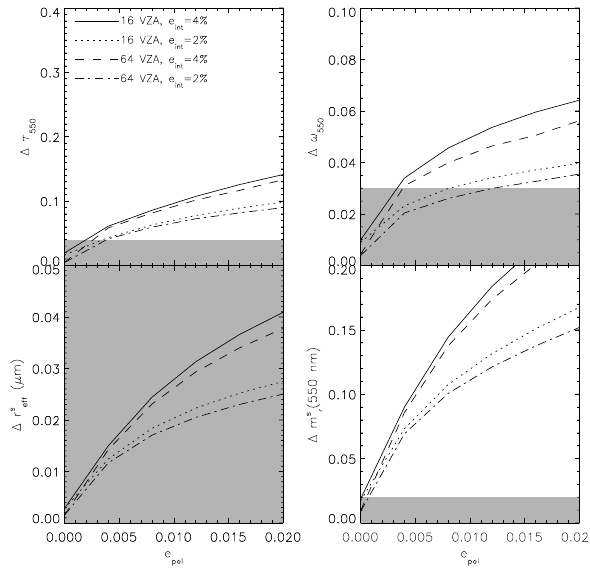
Fig. 5. Same as Fig. 4 but for errors that are correlated for different wavelengths and different viewing angles. Here, an exponentional decay is assumed of the correlation with wavelength and viewing angle, where the correlation is reduced to 1/ e for wavelength differ- ences of 100nm and viewing angle differences of 60 ◦